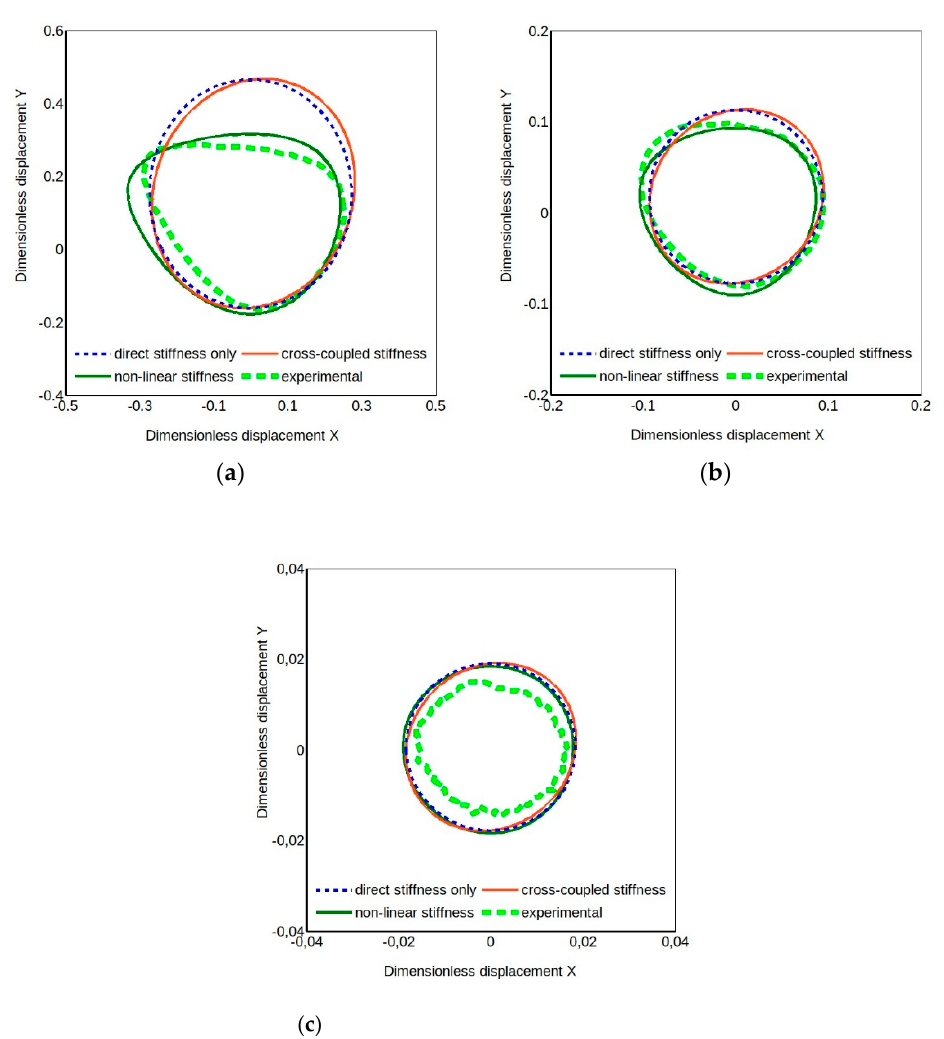
Figure 7. Calculated and experimental orbits of the four-pad TPJB for three different models with load dependent direct stiffness coefficients and two loads (L2>L1): ( a ) L1-36%, ( b ) L2-17%, ( c ) L2-3%.